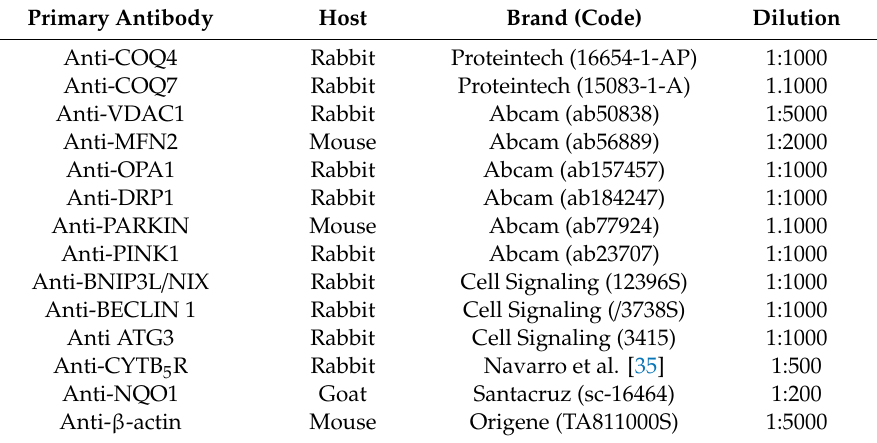
Table 1. Primary antibodies used in this study.